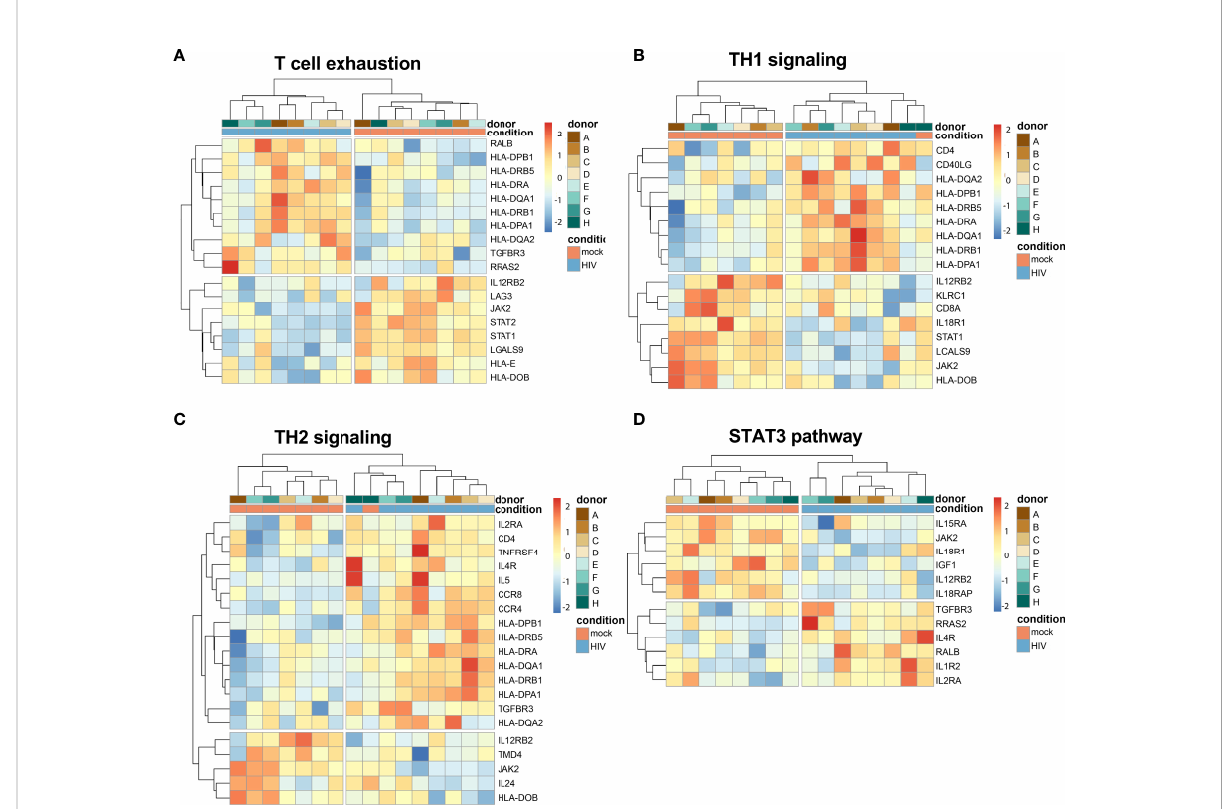
FIGURE 8 Transcriptomic data shows an activation of molecules involved in T cell exhaustion. Transcriptomic data set of HIV exposed and unexposed DCs with data from 8 individual donors/experiments was analyzed using heatmap package to provide hierarchic clustered heatmaps of T cell exhaustion (A) , TH1 signaling (B) , TH2 signaling (C) , and STAT3 pathways (D) with genes recognized in IPA to belong to these